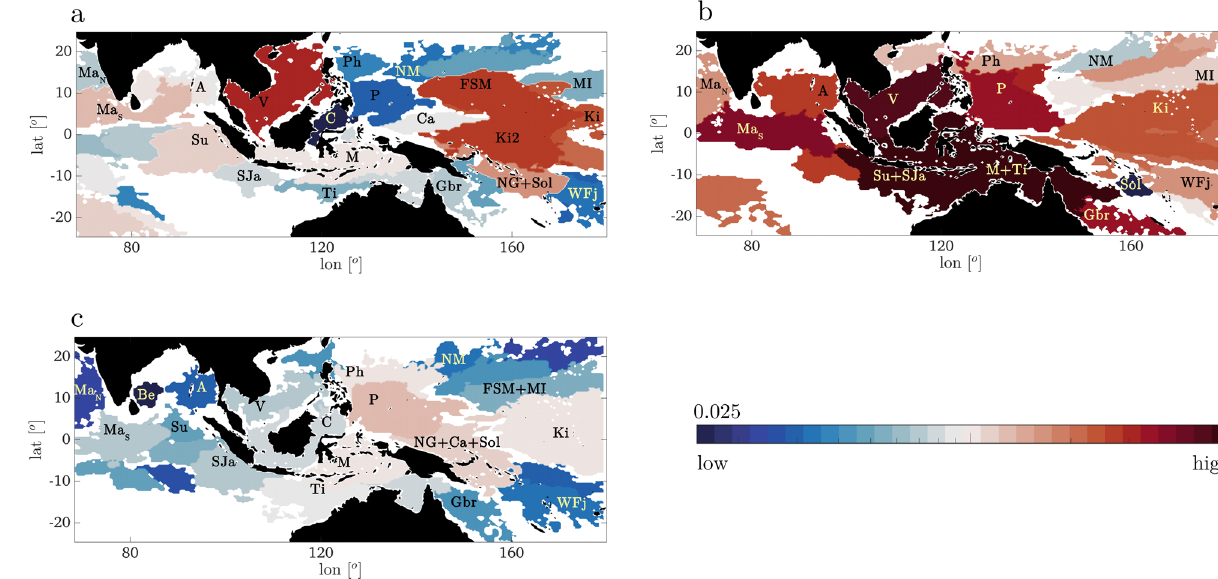
Fig. 3 Inferred domains. Domains over the period 1993 – 2017 in the CT and Indian Ocean for τ max = 2 months for aggregated ( a ) El Niño, ( b ) La Niña, ( c ) neutral years, colored according to their strength value. In each period, domains with strength below the 20th percentile (computed for that period) are not shown. Strengths are normalized by 6 × 10 6 , and the color scale is